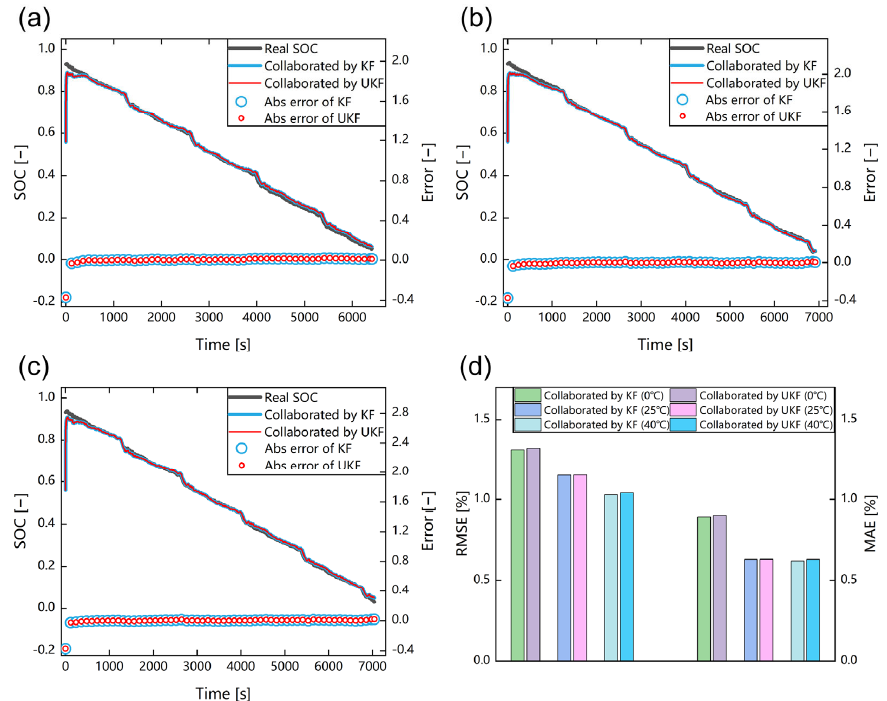
Figure 8. SOC estimation results with end ‐ cloud collaboration system for FUDS driving cycle under different temperatures with an incorrect initial value of 60%. ( a ) Estimation result under 0 ◦ C. ( b ) Estimation result under 25 ◦ C. ( c ) Estimation result under 40 ◦ C. ( d ) RMSE and MAE analysis for all estimation Table 3. RMSEs and MAEs of SOC estimation results with end ‐ cloud collaboration system under different temperatures with incorrect initial value of 80% and 60%.